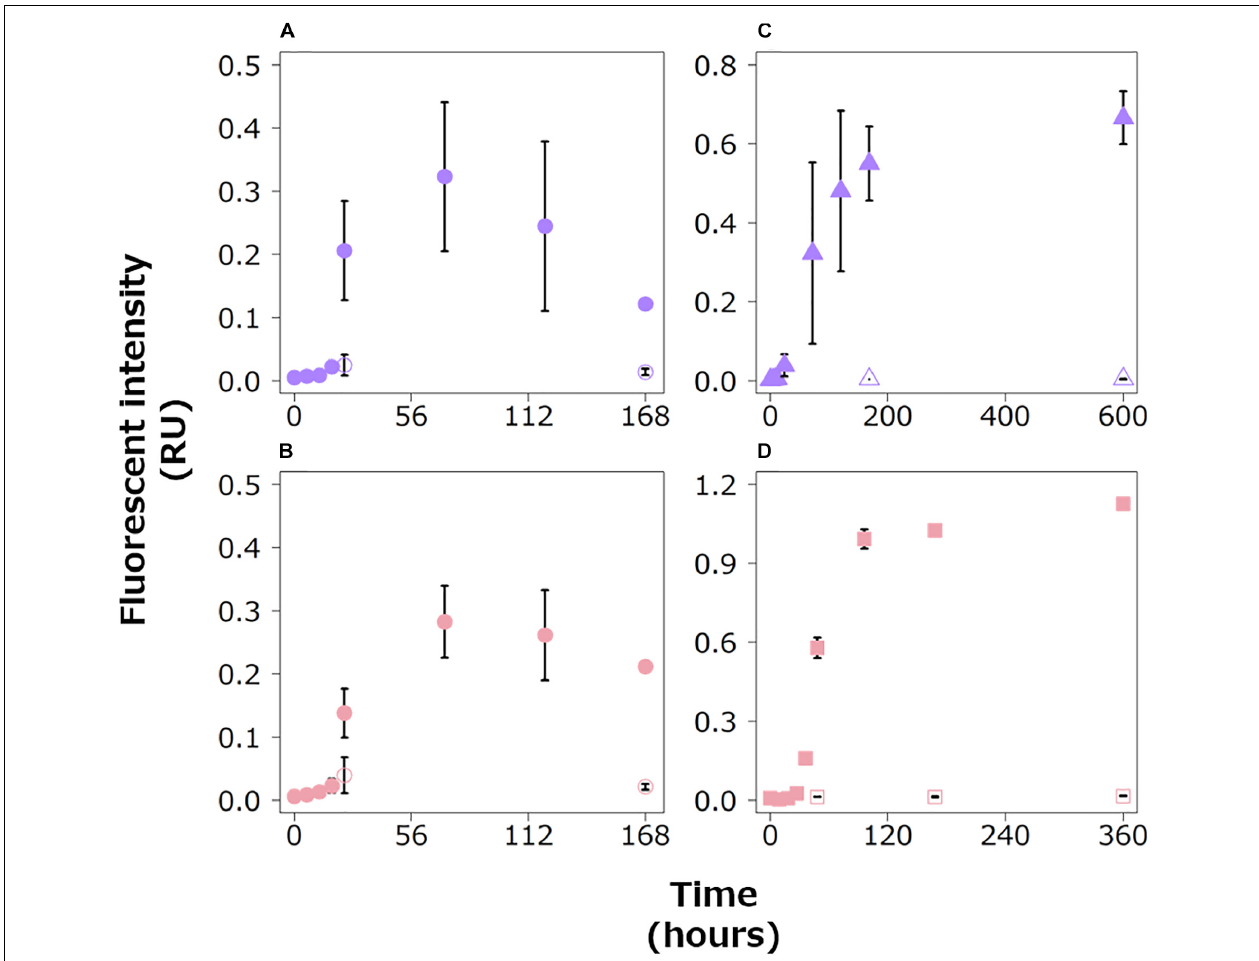
FIGURE 3 | Changes in the fluorescence intensities of protein-like FDOM in the Alt (A,B) , Vib (C) and Pha treatments (D) . The purple and pink symbols indicate tryptophan-like (A,C) and tyrosine-like peaks (B,D) , respectively. The closed and open symbols represent the experimental treatment and control treatment, respectively. The error bars indicate standard deviation of triplicate incubation